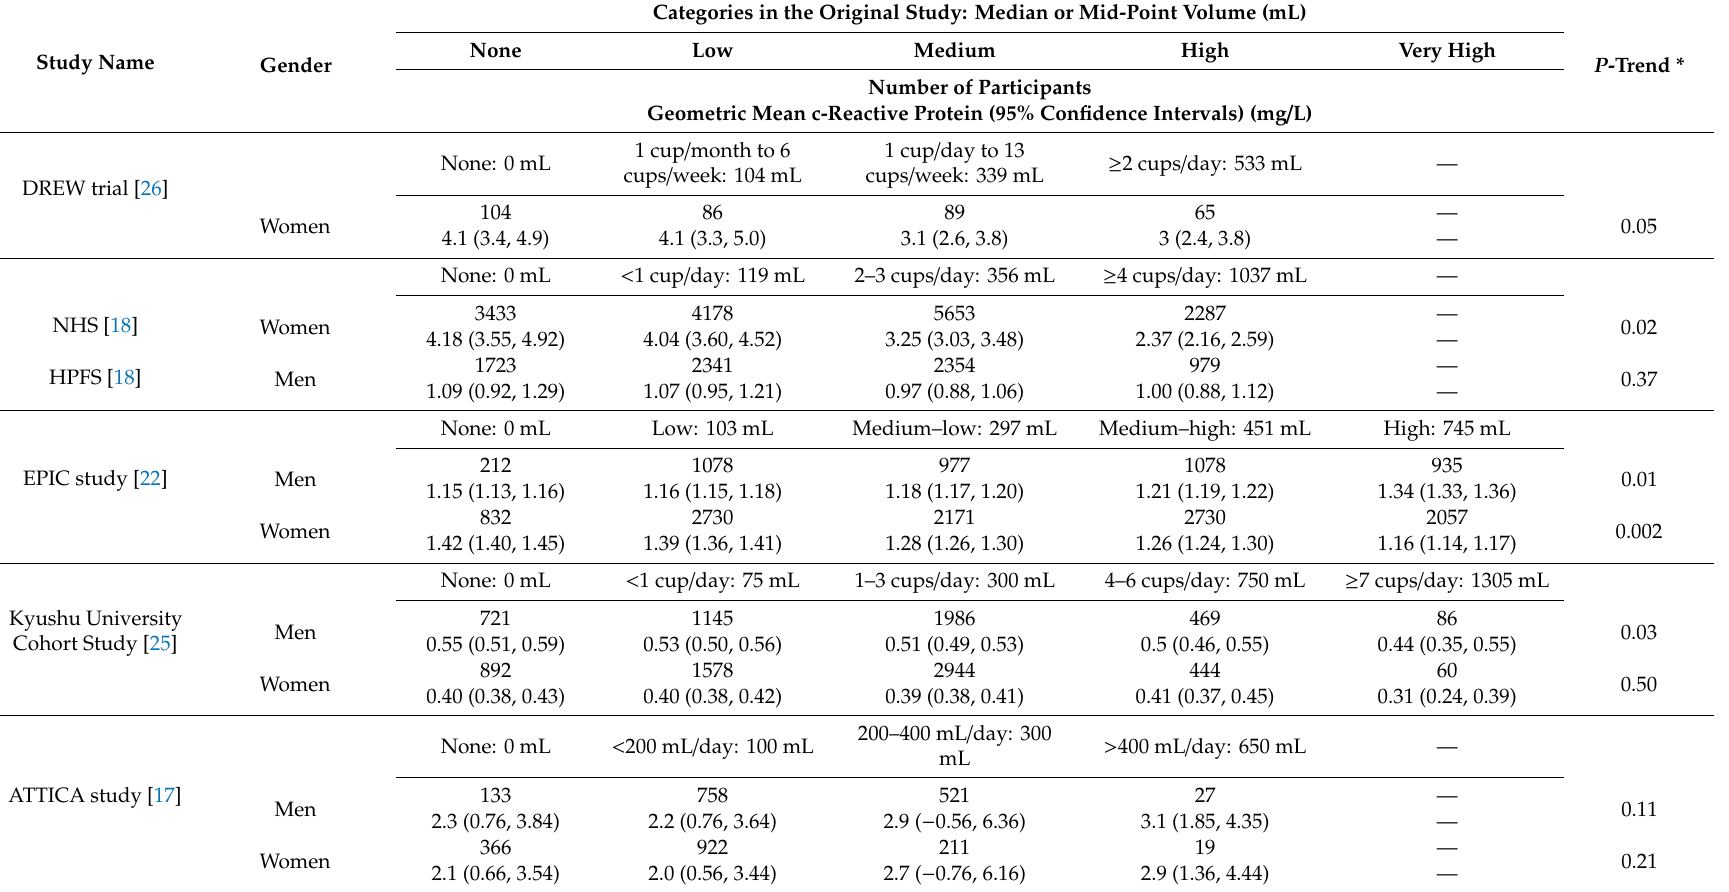
Table 2. C-reactive protein levels by co ff ee consumption by